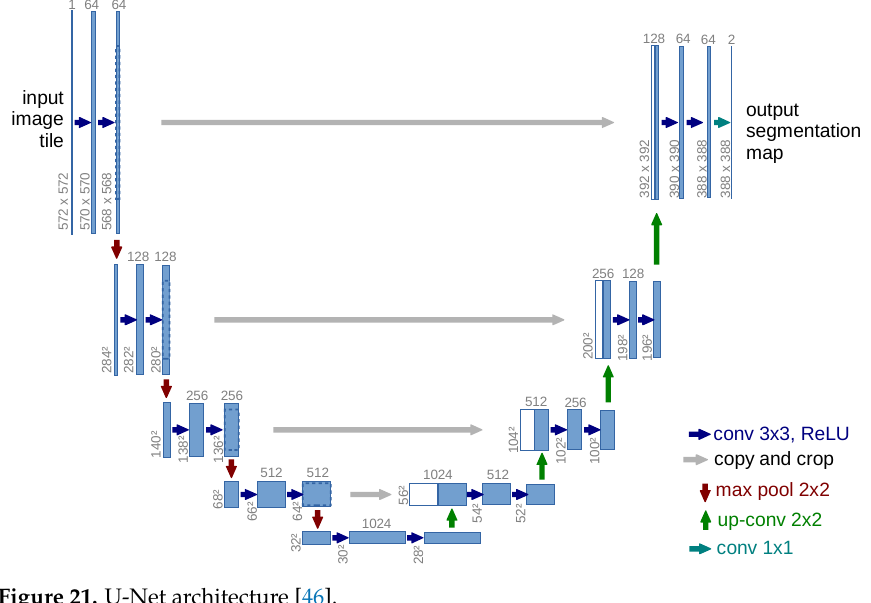
Figure 21. U-Net architecture